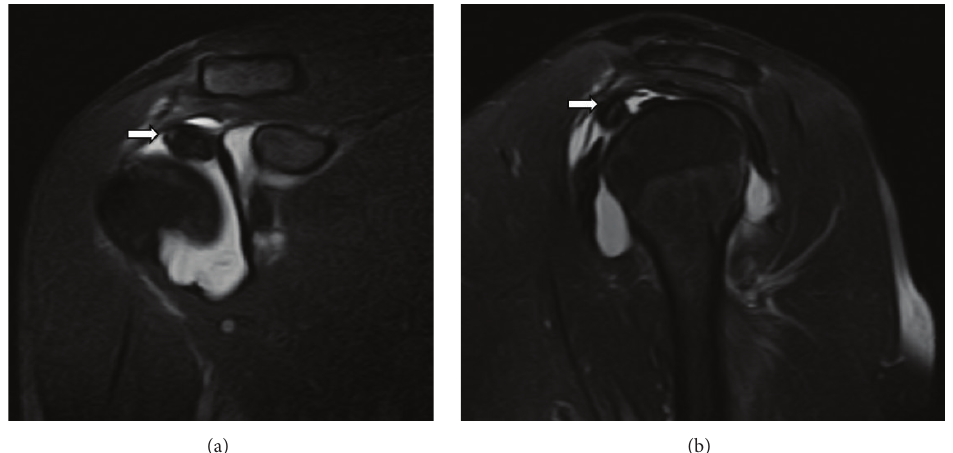
Figure 1: MR imaging of osteochondroma: coronal (a) and sagittal (b) T2 TSE SPIR images.